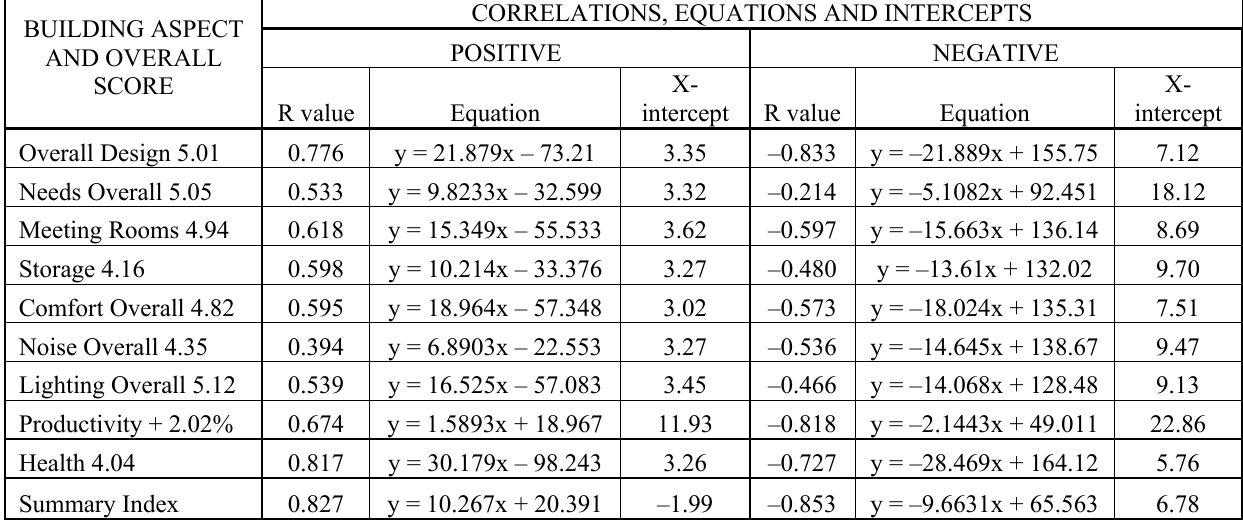
Table 3. Correlation Coefficients, Lines of Best Fit and X-axis intercepts for different aspects of the